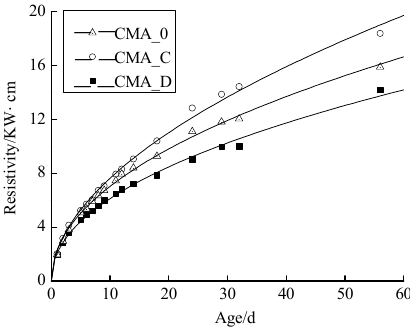
Figure 15. The resistivity of the CMA_0 and CMA_Cgroups: ( a ) CMA_0; ( b ) CMA_C.